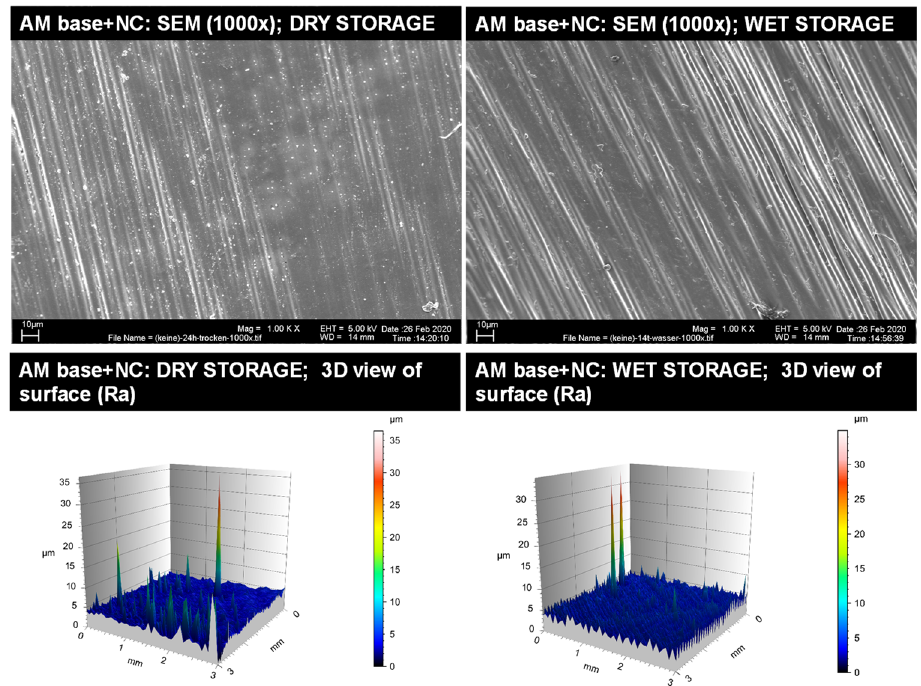
Figure 4. Qualitative insight of the AM base group with no surface condition (NC) via SEM imaging in 1000× magnification ( top ) and surface roughness profiles ( below ) for dry storage ( left ) and wet storage ( right ). Please note the differences in the scaling of the roughness profiles.